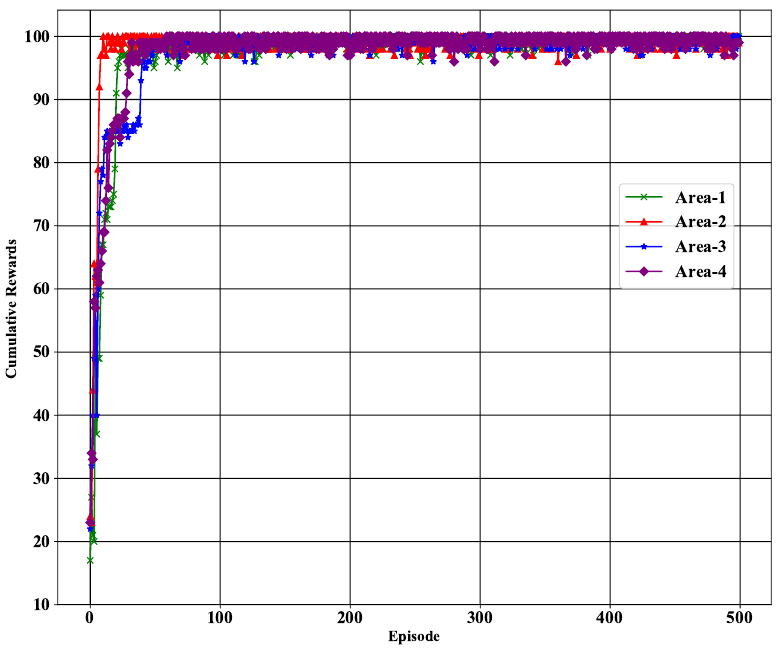
Figure 8. Cumulative rewards for each